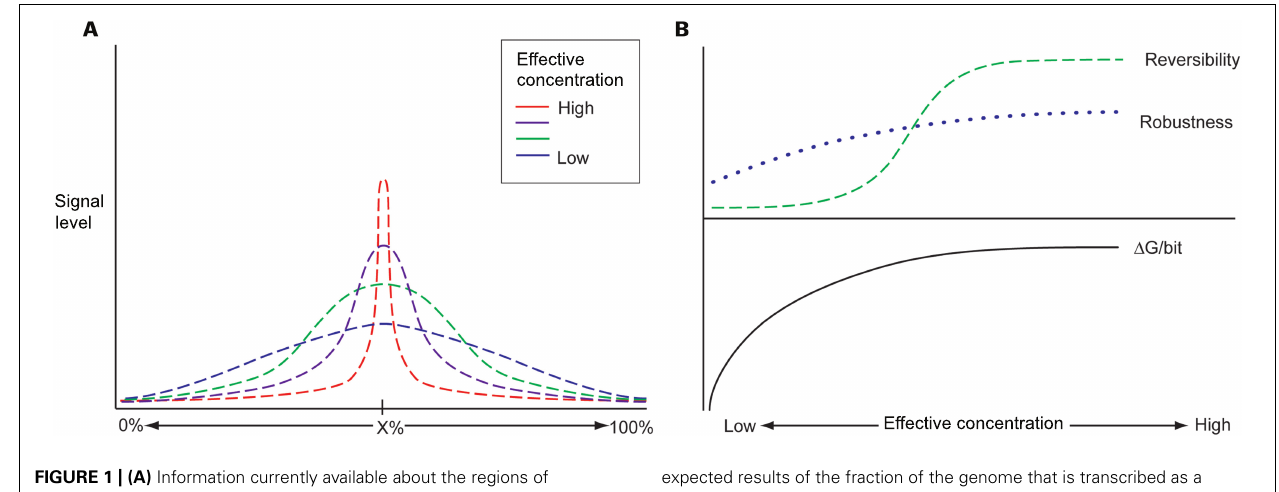
FIGURE 1 | (A) Information currently available about the regions of dark matter transcription and the actual RNA molecules made from these region comes from various types of experiments and databases. There is relatively little overlap between these different databases suggesting that the actual extend of dark matter transcription is far greater than any one database suggests. (B) A theoretical curve showing